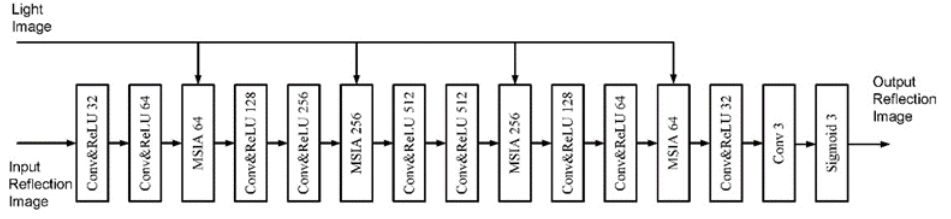
Figure 2. Reflectance restoration net.